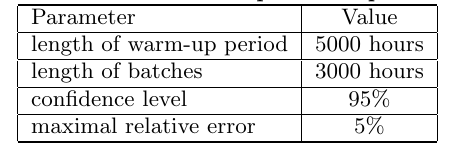
Table 2: Overview of the precision